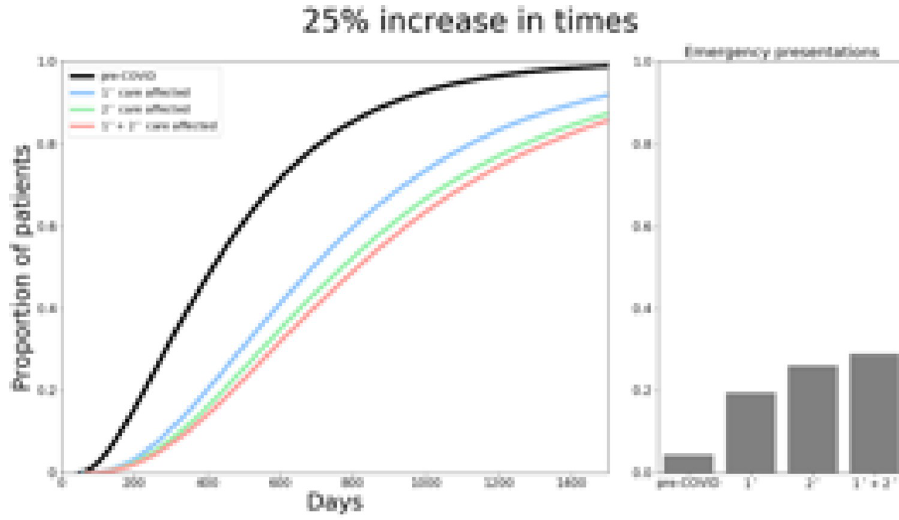
Fig 2. Total time from symptom onset to diagnosis and proportion of emergency presentations if primary, secondary and both care services are increased by 25%.